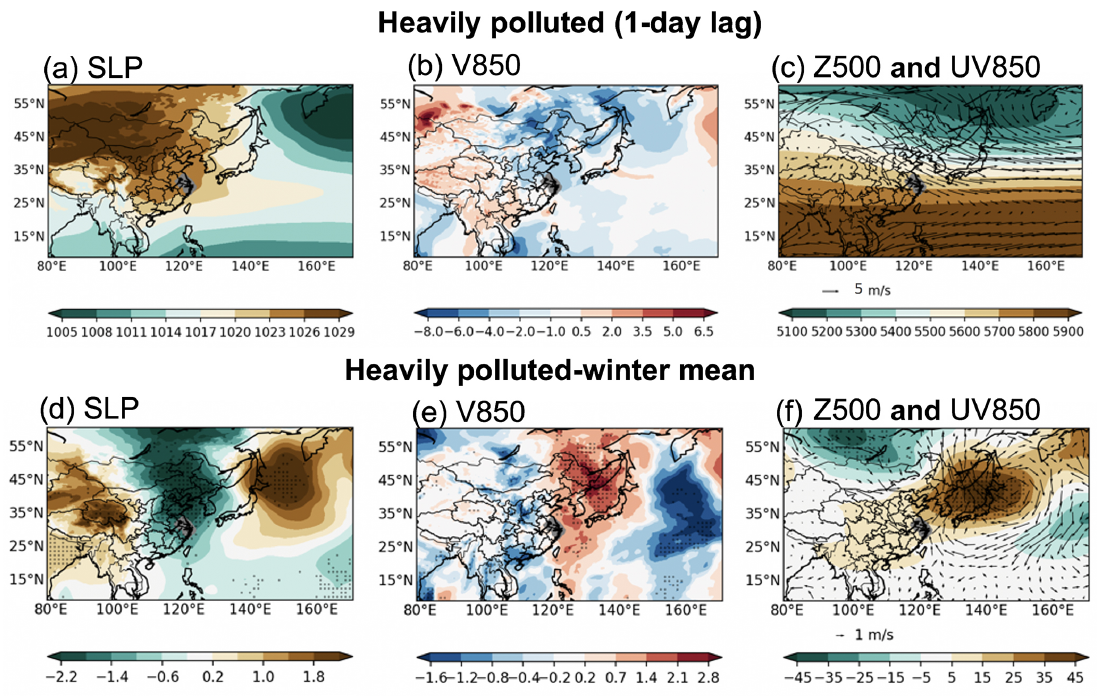
Figure 6. Average (a) SLP (hPa), (b) V850 (ms − 1 ), (c) Z500 (m, shading) and 850hPa wind (ms − 1 , vector) 1d before heavily polluted days (24h PM 2 . 5 above the regional 90th percentile), and difference (1d before heavily polluted days minus winter mean) for (d) SLP, (e) V850, (f) Z500 and 850hPa wind during DJF 2013–2017 over YRD. For V850 (b, e) , blue regions represent northerlies and red regions represent southerlies. Dotted regions in (d–f) mark statistically significant differences at the 95% level (determined through a bootstrap resampling method). Grey shading represents the YRD region.